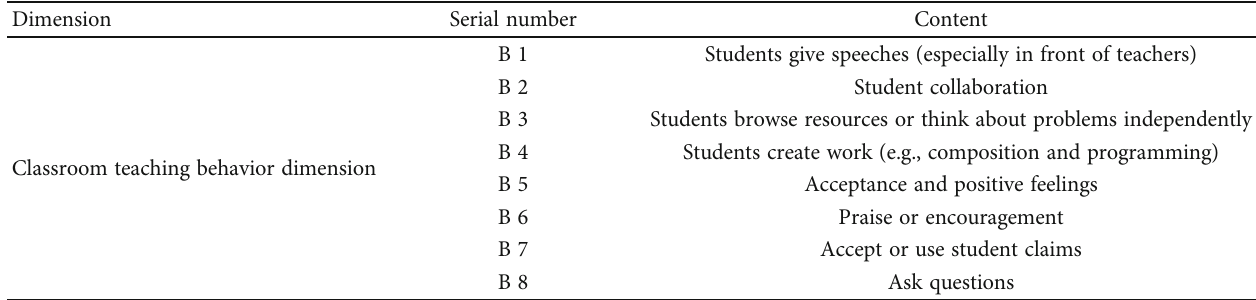
Table 2: Faculty teaching behavior